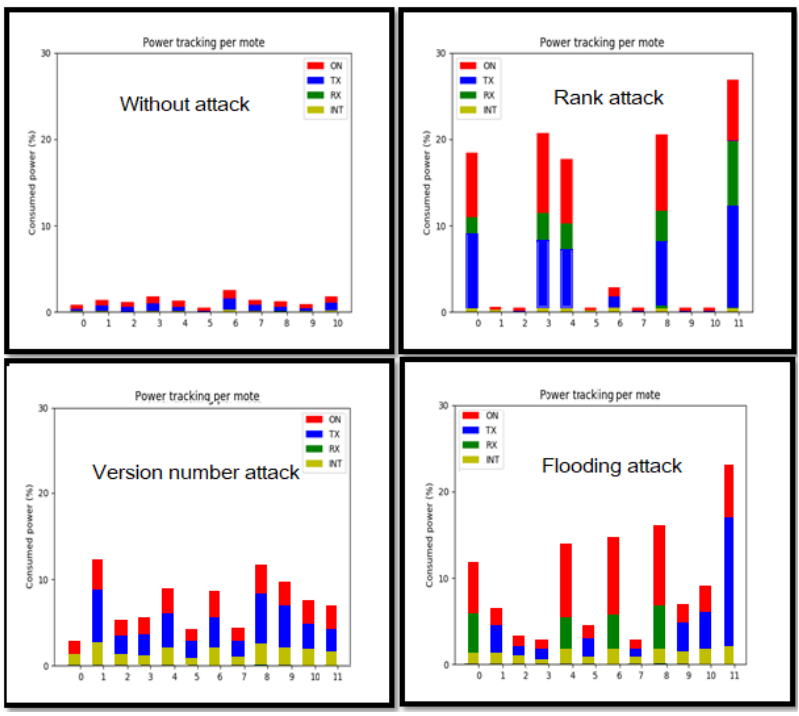
Figure 13. Power tracking per each mote for each